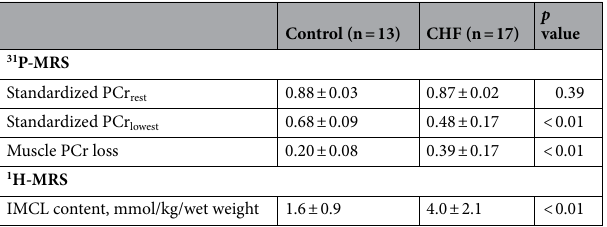
Control (n = 13) CHF (n = 17)